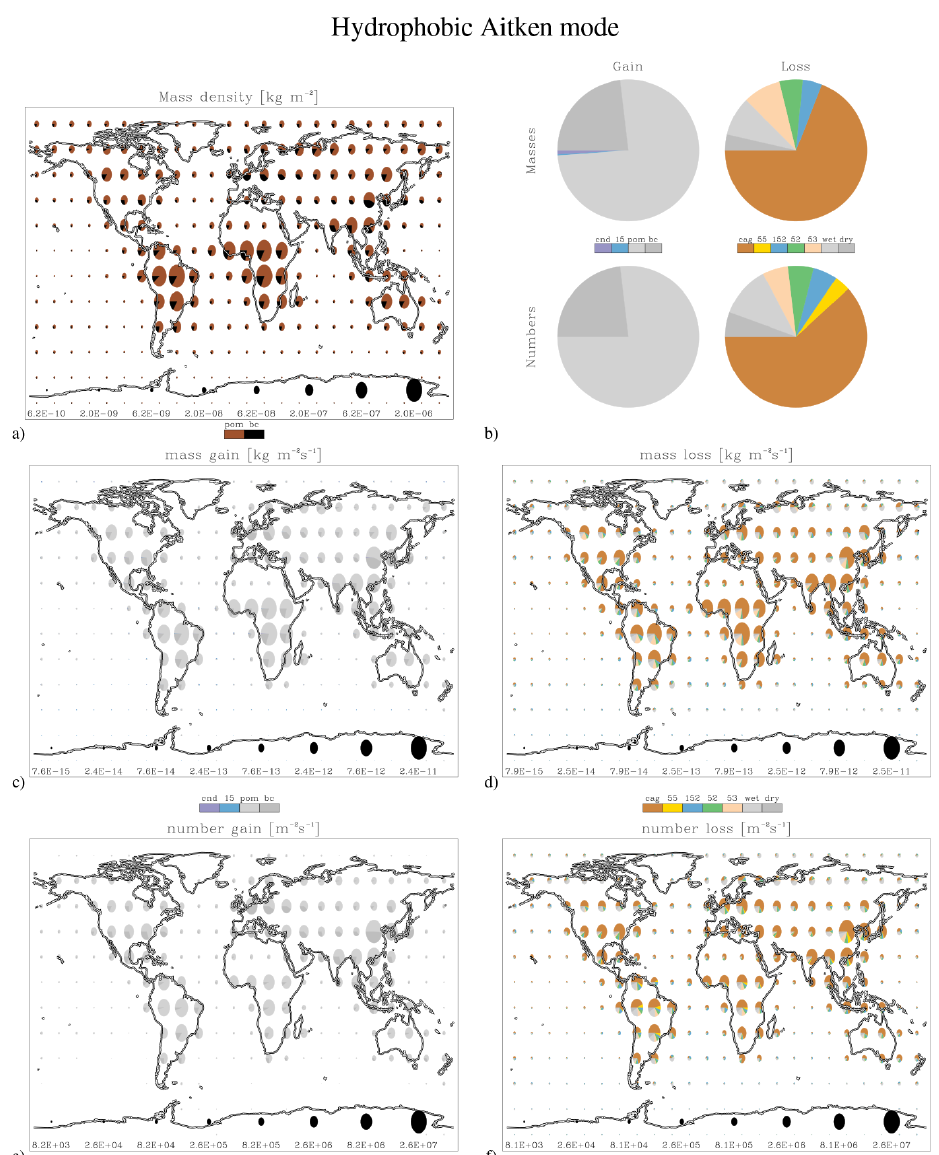
Figure 8. Global distribution of annual burdens (a) and tendencies ( b, c, d, e and f ) of the hydrophobic Aitken mode. The colors indicate either species (defined in Table 3) or processes (defined in Table 2). The pie chart shows fractional contributions, while the radius of the pie indicates total column burden or total column tendency (logarithmic scale as shown in black at the bottom of panels a, c, d, e and f ). Panel b shows a global average of the